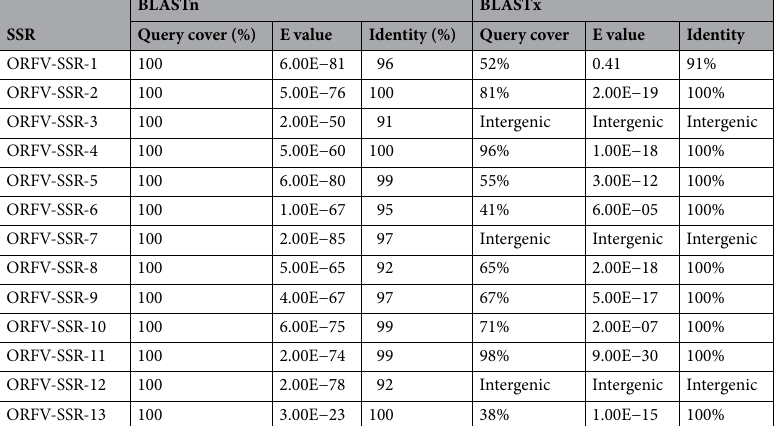
Table 3. Alignment of the 13 sequenced microsatellite markers (partial) against the complete genome present in the NCBI